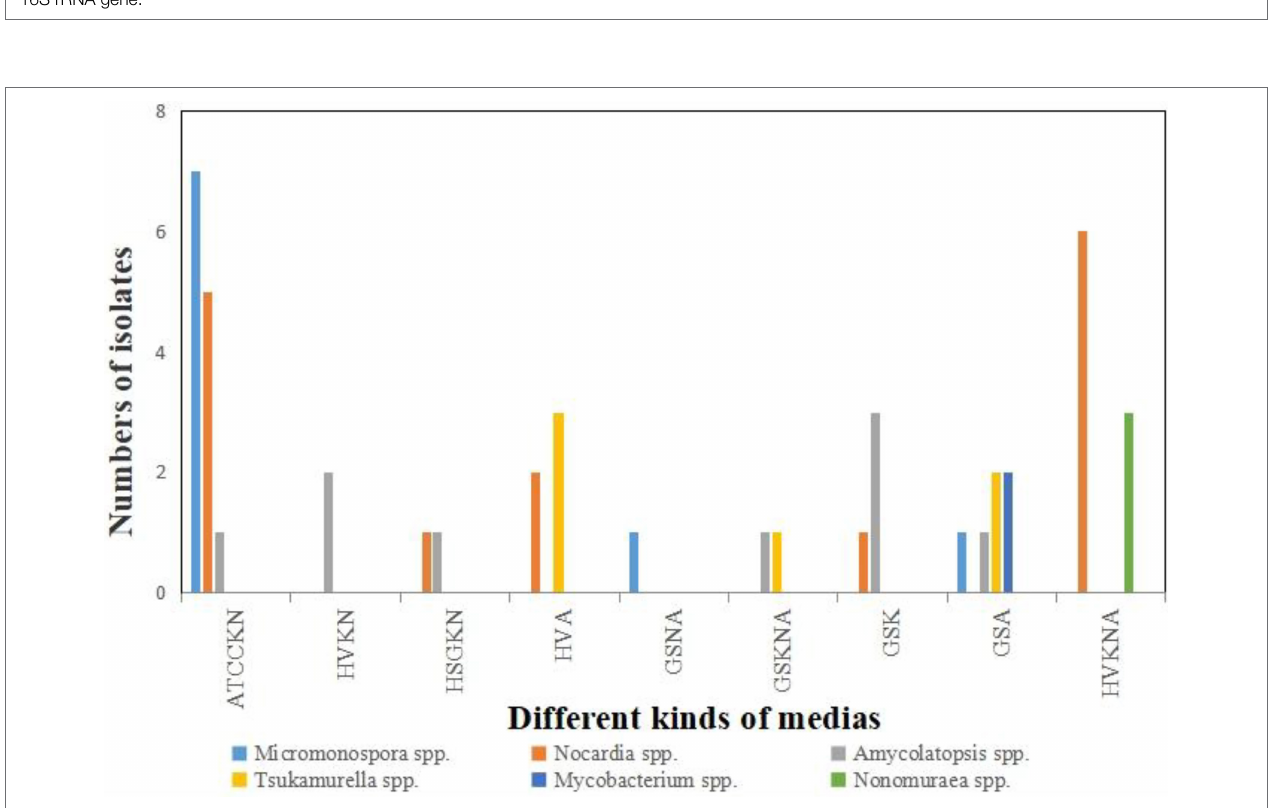
FIGURE 12 | The number of rare Actinobacteria recovered from each selective